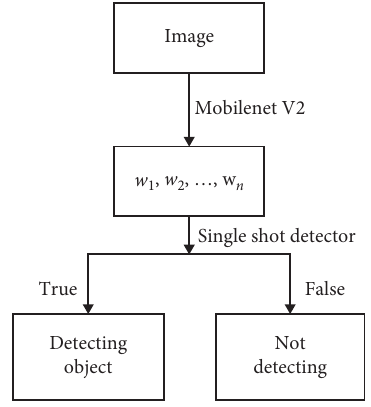
Figure 11: Determining of the object in SSD.